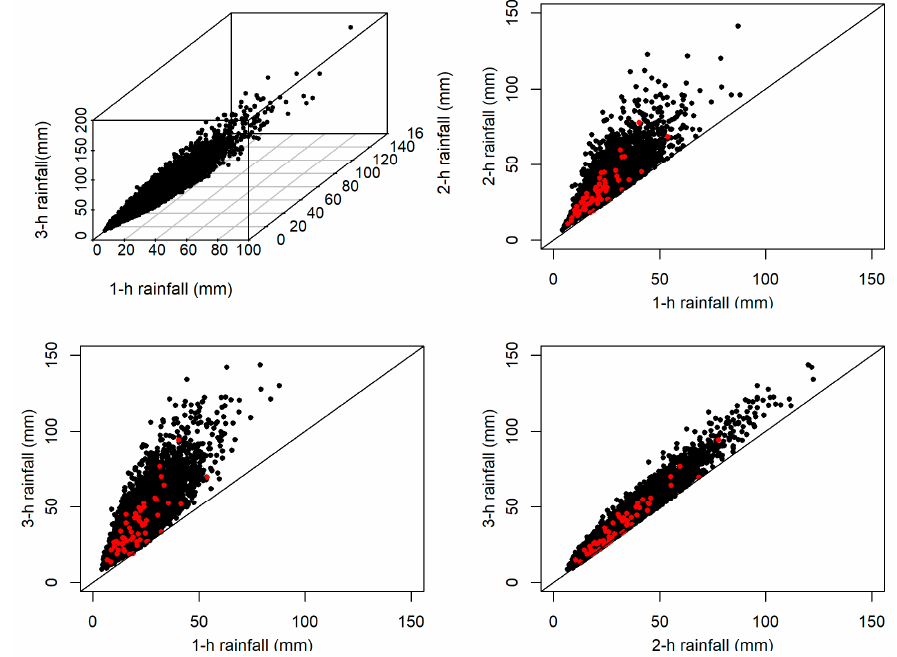
Figure 7. Plots of 10,000 random rainfall values generated by the copula model. Black dots are random values; red dots represent observed real rainfall data.